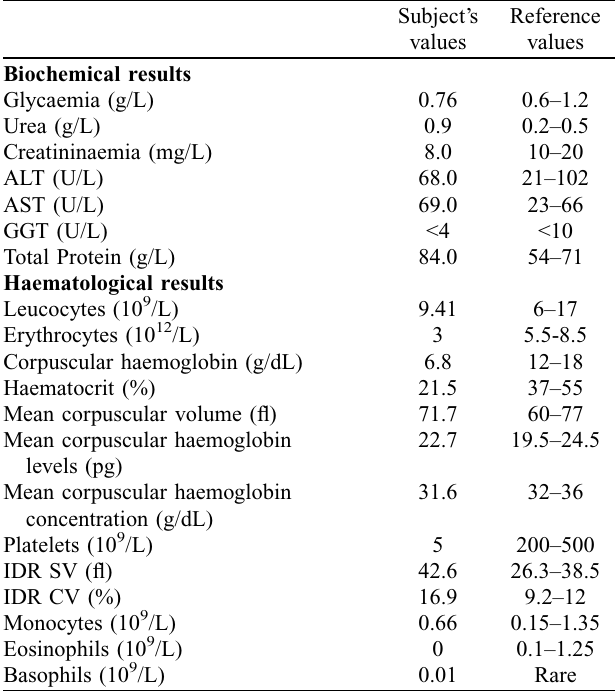
Table 1. Results of biochemical and haematological analyses of the dog infected with Trypanosoma